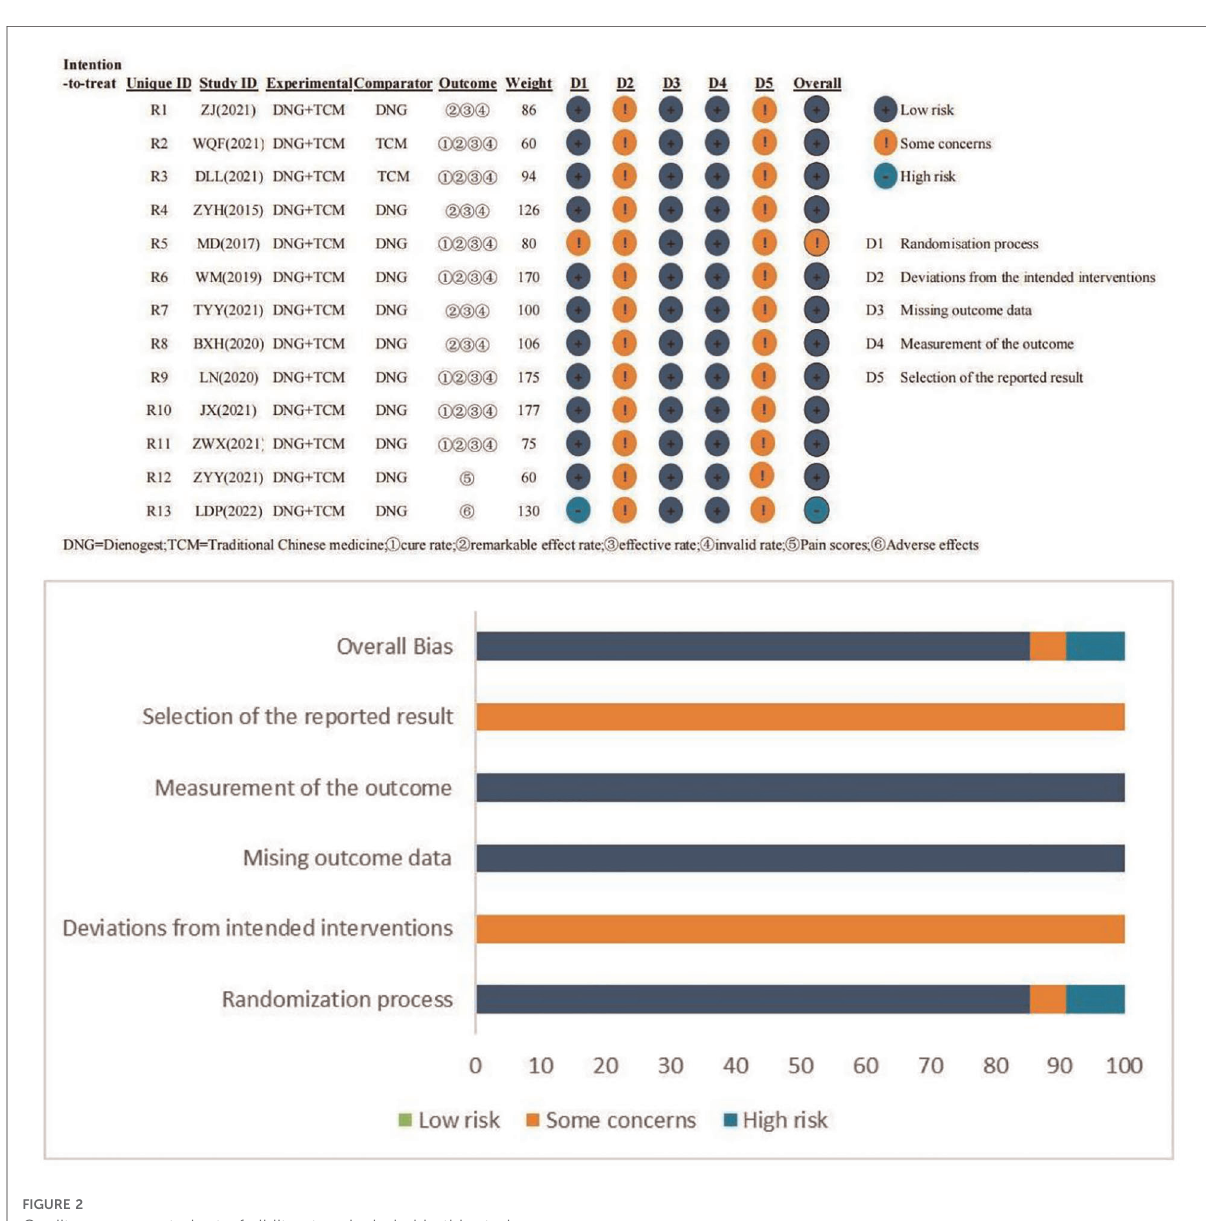
FIGURE 2 Quality assessment chart of all literature included in this